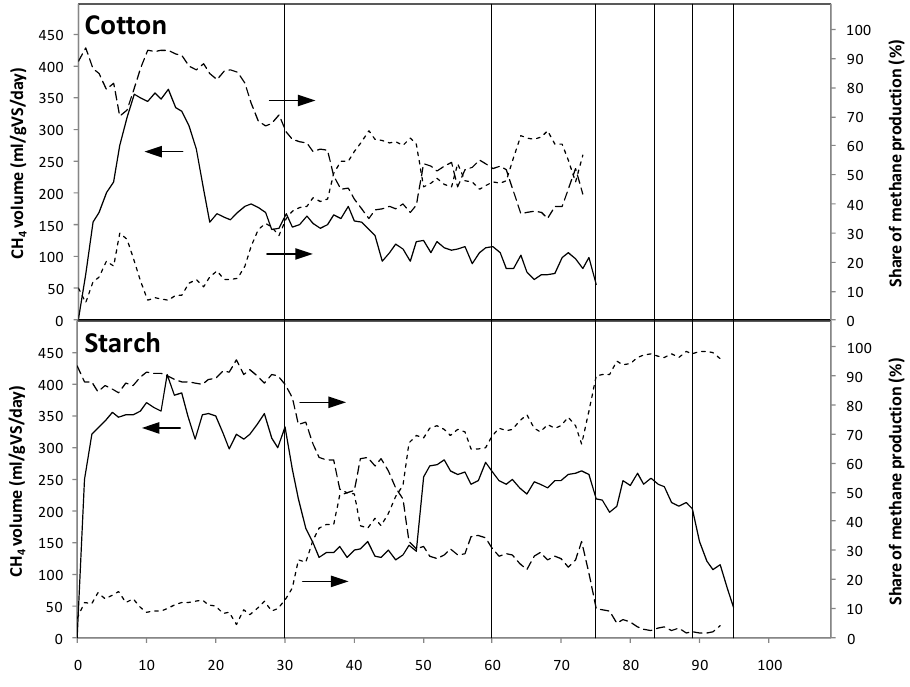
Figure 2. Total methane production in open system for cotton and starch with --- % share in CSTR and - - - % share in